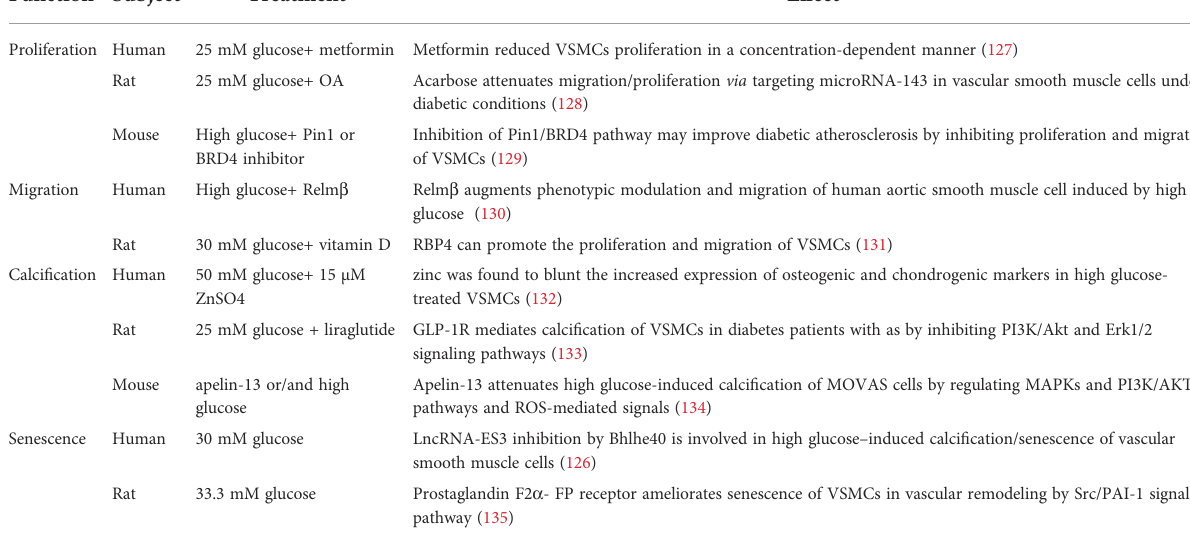
Table 3 Mechanisms of high glucose in VSMCs function.